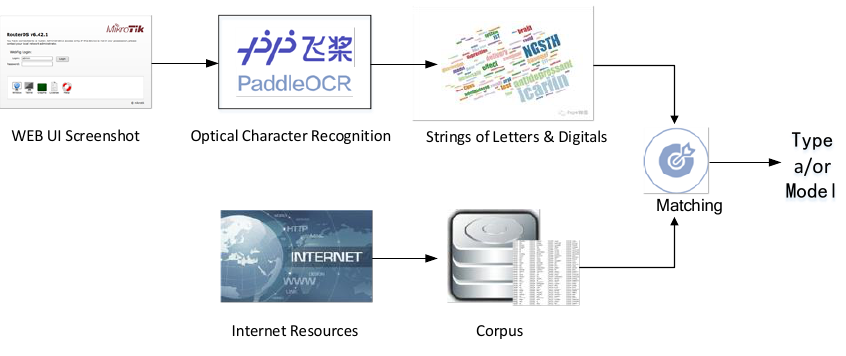
Figure 4. Device Type/Model Identifying based on